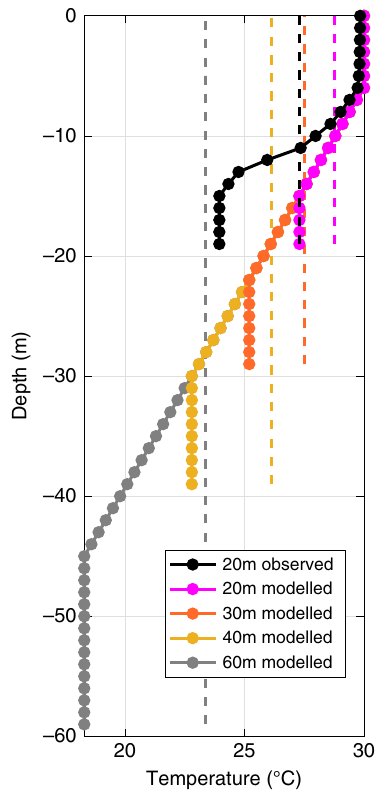
Fig. 4 Initial temperature structure for the different model cases. The observed pro fi le (black solid line) and its vertical average (black dashed line) are from site CP at 23:00 on August 25, 2018, and used as the initial thermal structure for the model runs with ‘ 8/25 condition ’ and ‘ 8/25 condition (mixed) ’ in Table 1, respectively (cases A1 – A3 and B1 – B3). The colored solid and dashed lines indicate the idealized strati fi ed (Cases C1a, C2a, C3a, and C4a) and mixed (Cases C1b, C2b, C3b, and C4b) initial temperature conditions, respectively, for the four additional model scenarios with different depths (Table 1). Note that the vertical dash line indicates the depth-average temperature associated with a given strati fi ed case, projected over the full water column to represent ‘ mixed ’ temperature structure for that scenario (e.g., Cases C1a and